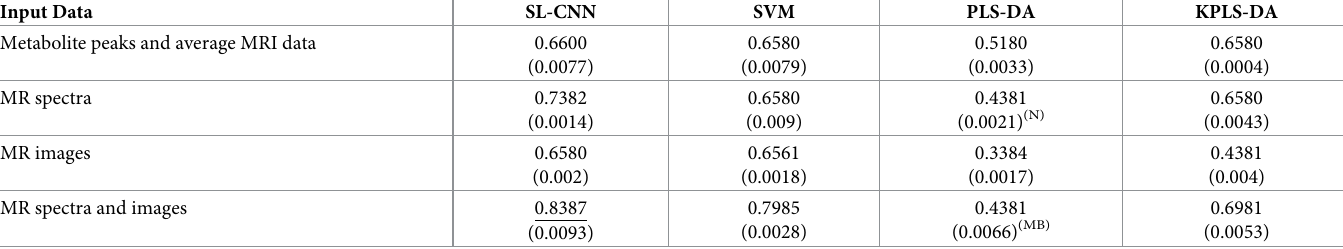
Table 3. Average classification MCC score assessed by LOPO-CV to separate voxels with the grade III versus grade IV in the brain tumor dataset. MBPLS-DA is used instead of PLS-DA for the last line given the multiple types (i.e. MR spectra and MR images). Average MRI data are obtained from MR images by averaging pixels intensities for all voxels. Metabolites peaks, corresponding to brain metabolites, are quantified from MR spectra. Full MR spectra means that complete MR spectra are used as input data. Standard deviation is reported below each score between brackets. The best results are